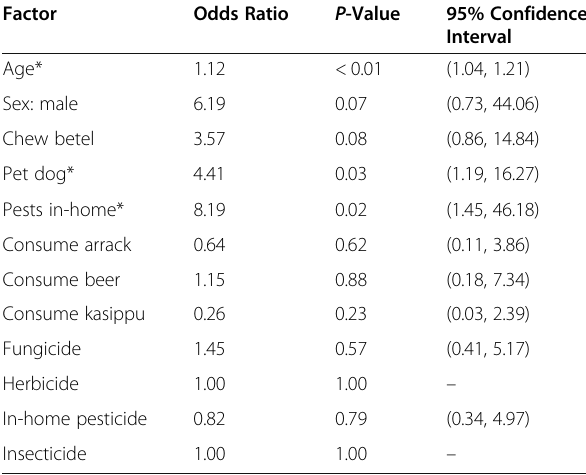
Table 2 Adjusted Odds Ratios for CKDu Using Backward Stepwise Approach with Forced Inclusion of Primary Exposures of Interest – Pesticide Use and Alcohol Consumption Factor